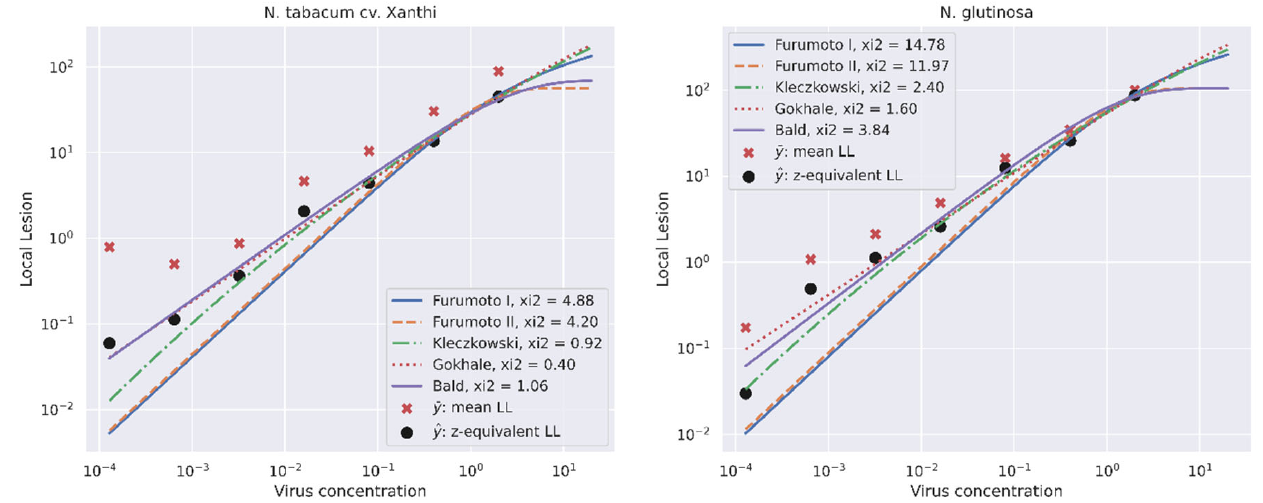
Figure 2. Mean number of the local lesions on N. tabacum cv. Xanthi nc (left) and N. glutinosa (right) against the virus concentrations in serially diluted ToBRFV suspensions with the dilution factor of 5 and starting concentration of 2 mg/mL plotted on log/log scale. Table 3. Mean number of observed necrotic local lesions on N. glutinosa with serially diluted ToBRFV suspensions and related transformed and computed based on the different models. Data transformation performed according to Section 4.5.